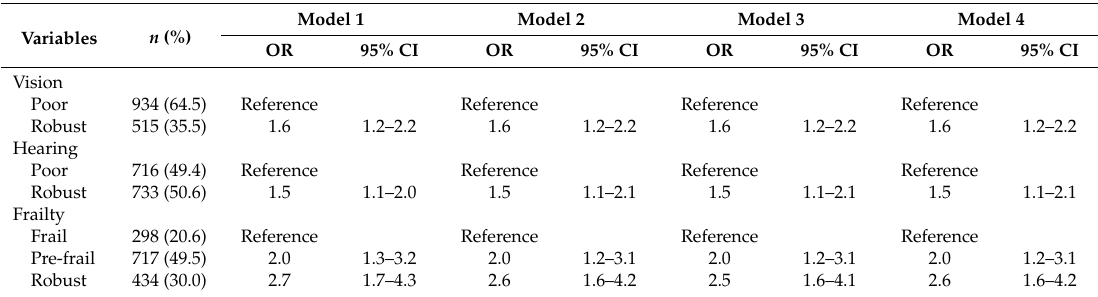
Table 5. Associations of sensory impairment and frailty with improvement in subjective memory after 12 months ( n =